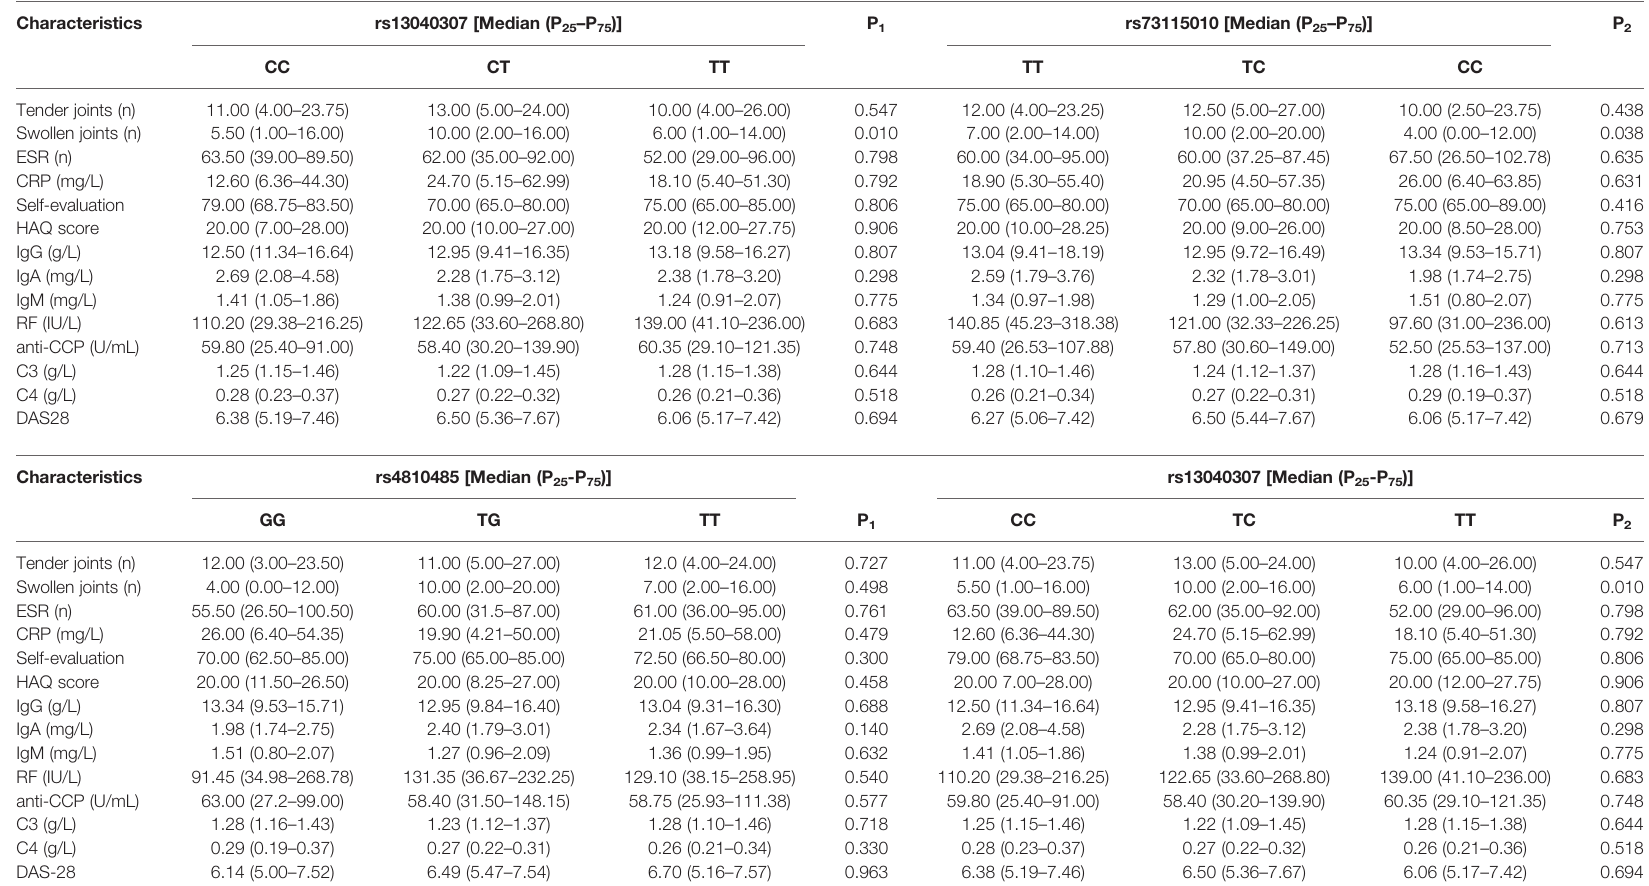
TABLE 4 | Association of disease activity parameters in RA patients with CD40 gene polymorphisms (rs1569723, rs13040307). Characteristics